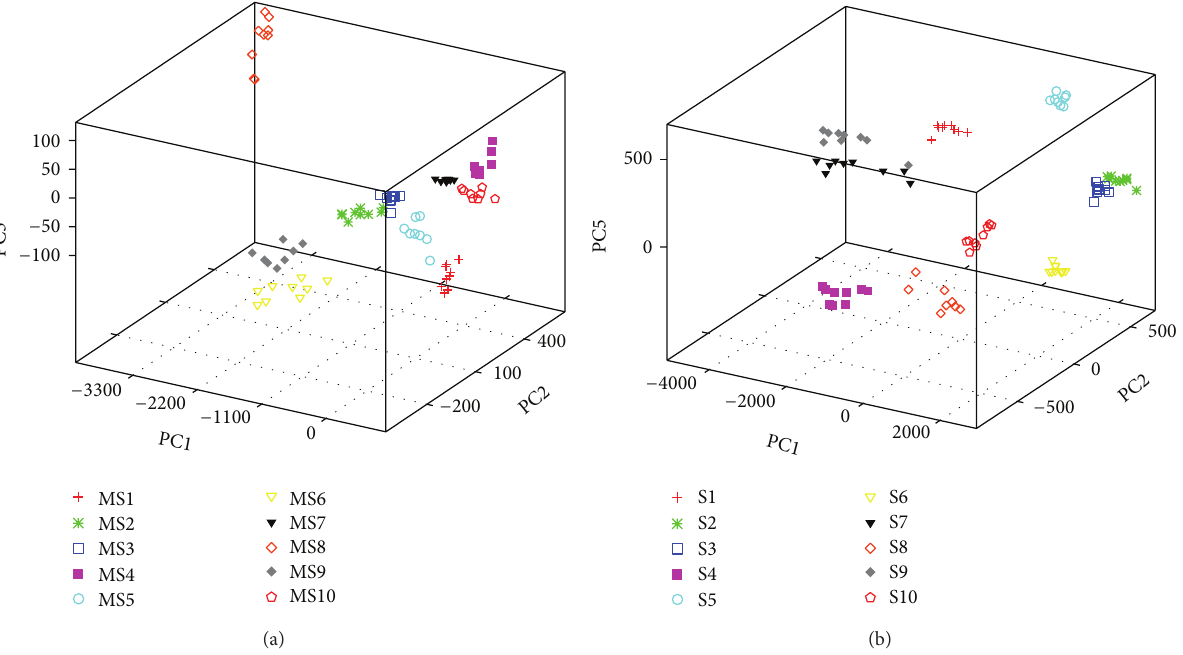
Figure 7: Intrasubject variability represented by three principal components, the first two principal components as shown by PC1 and PC2 and the fifth principal component as shown by PC5 for ten different subjects of (a) MIT-BIH arrhythmia database and (b) IIT (BHU) database.